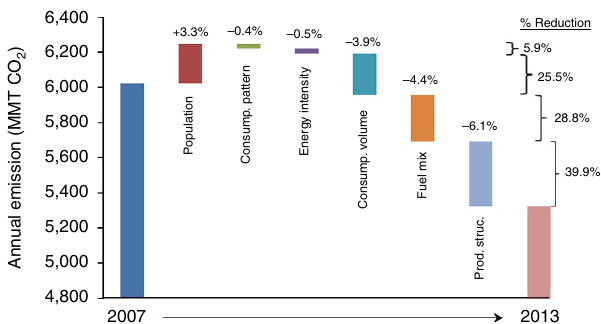
Figure 1 | Contributions of different factors to the decline of US CO 2 emissions 2007–2013. Numbers are taken from FDSH’s structural decomposition analysis that spans the whole time period. Changes in the fuel mix are responsible for a 4.4% decrease in energy-related emissions and 28.8% of the emissions decreases that occurred during this period. This amount exceeds that from changes in consumption volume (Consump. volume), but is less than that from changes in production structure (Prod. struct.).